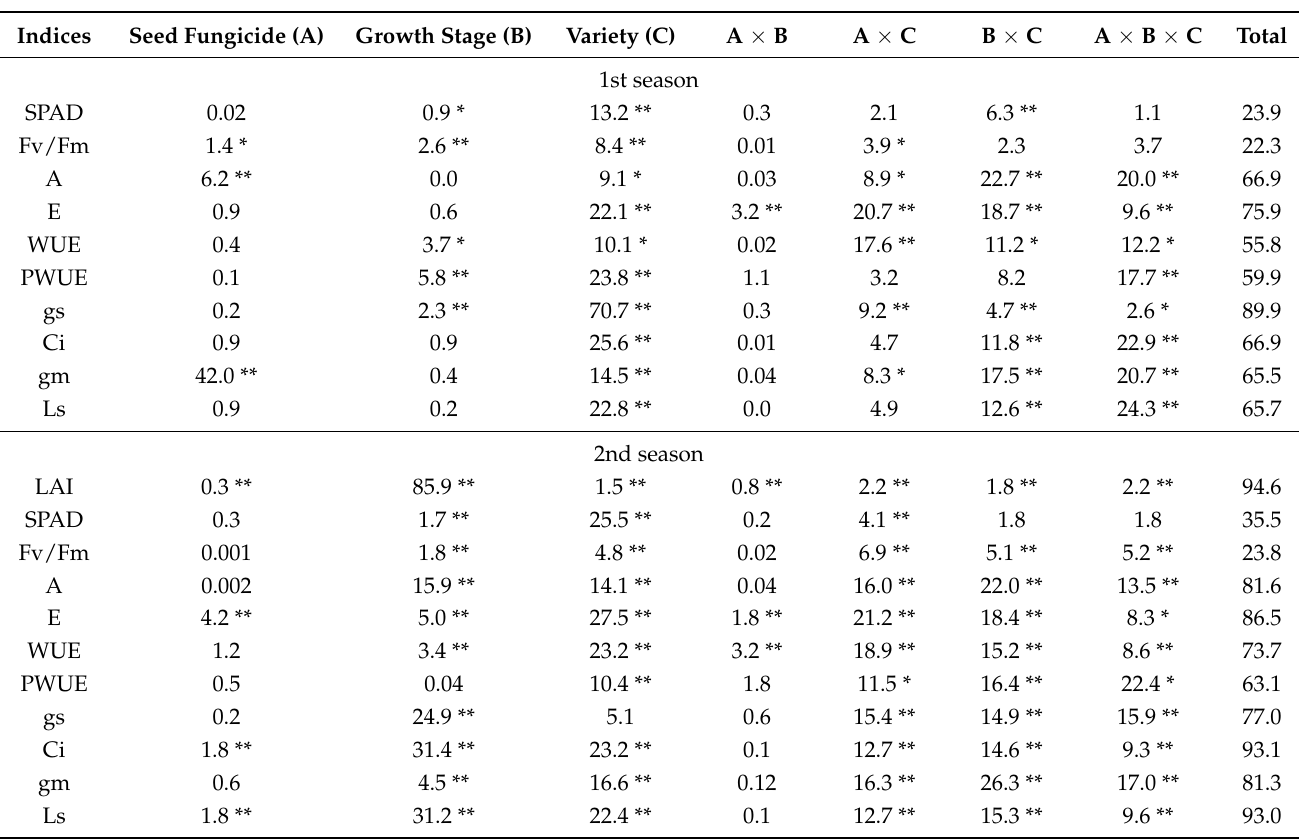
Table 2. Contribution (% of sum of squares) of seed fungicide, growth stage, variety, and their interaction to total variance in physiological indices of faba